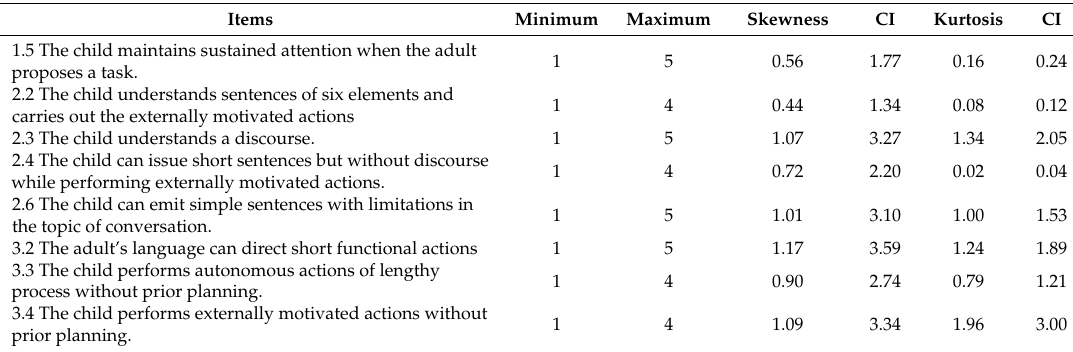
Table 4. Analysis of the Normality of the